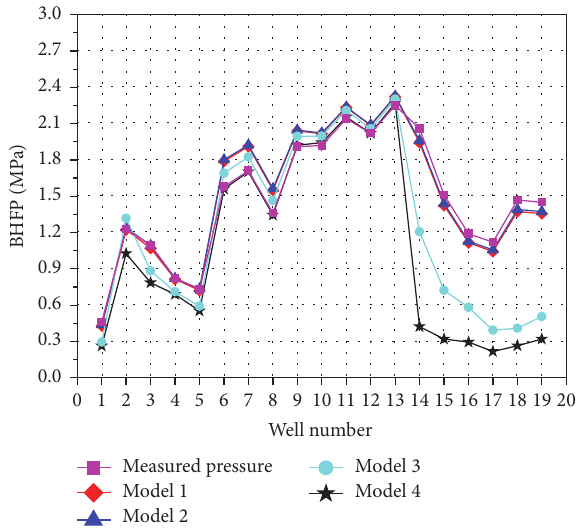
Figure 4: Comparison of calculated result with measured value.